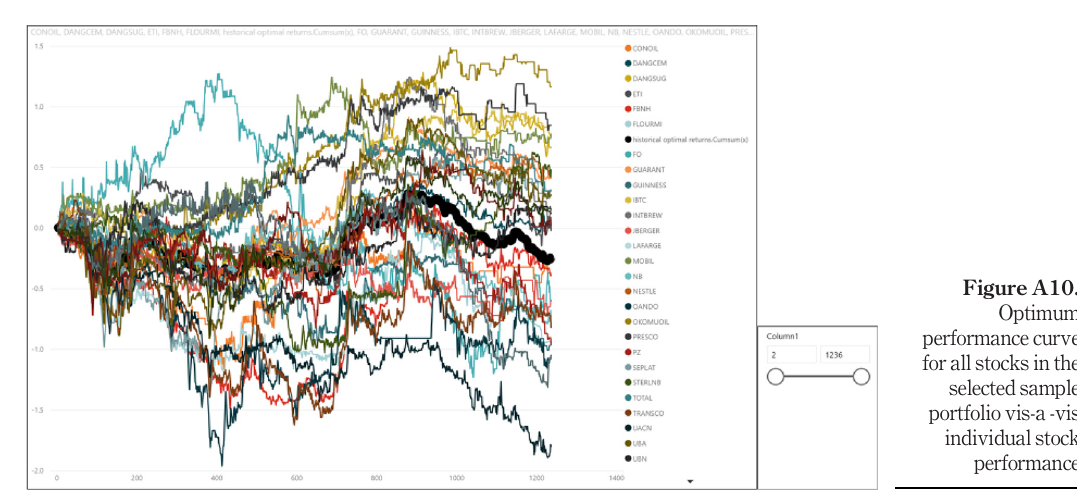
Figure A10. Optimum performance curve for all stocks in the selected sample portfolio vis-a -vis individual stock